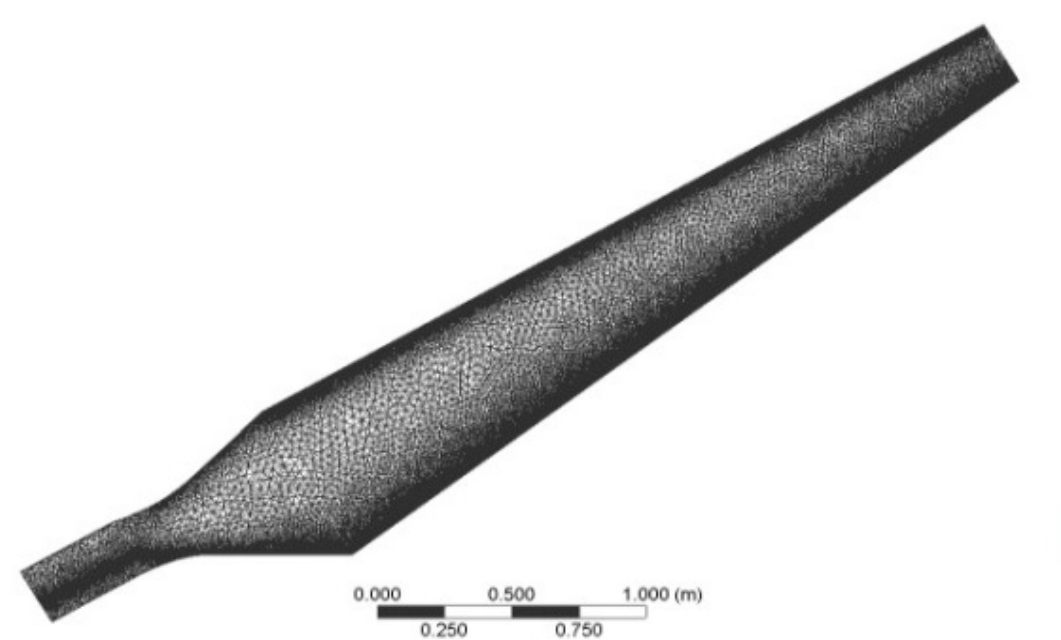
Figure 7. Discretized structure of a wind turbine.